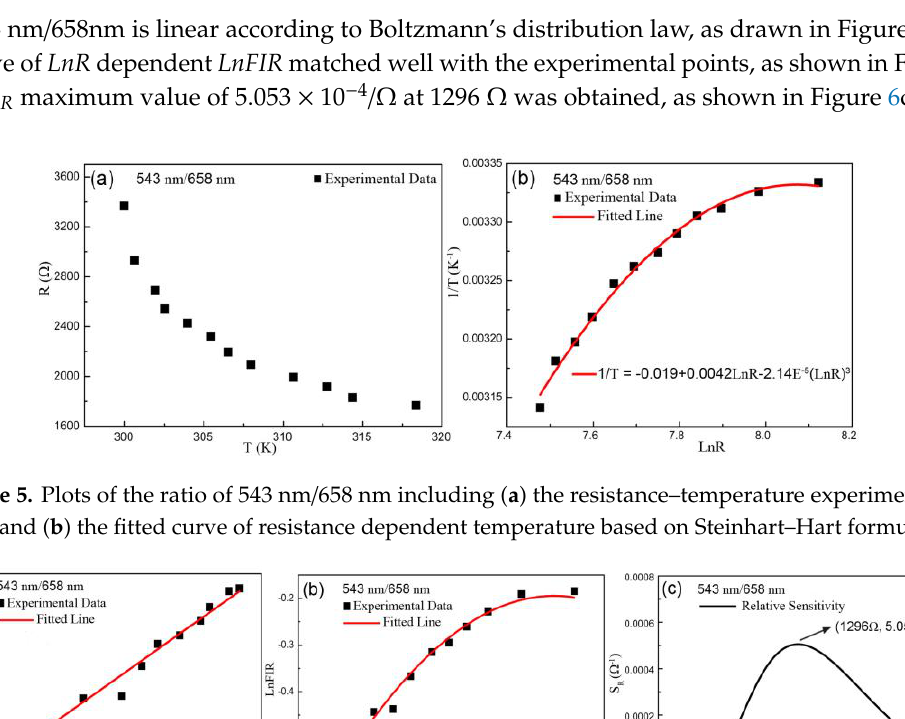
(4) where a 0, b 0 and c 0 are constants from fitted experimental data. Figure 4b describes that the experimental points can be well fitted by the formula in Equation (4) and LnR dependent LnFIR can be obtained. To estimate the performance quality of variable-resistance sensor, the relative sensitivity S R as a